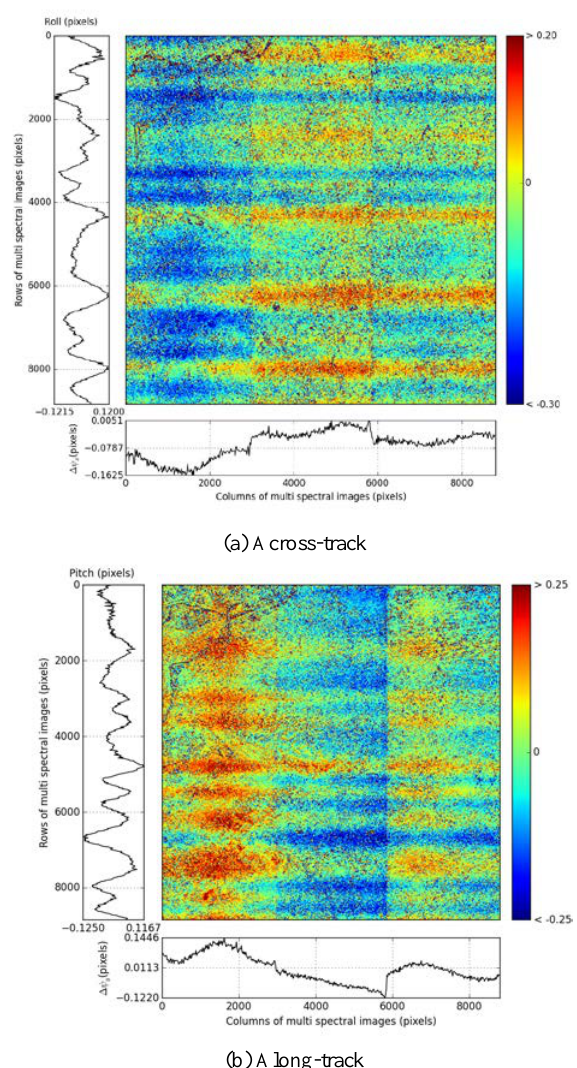
Figure 5 The band-to-band misregistration of Dengfeng dataset with cubic spline